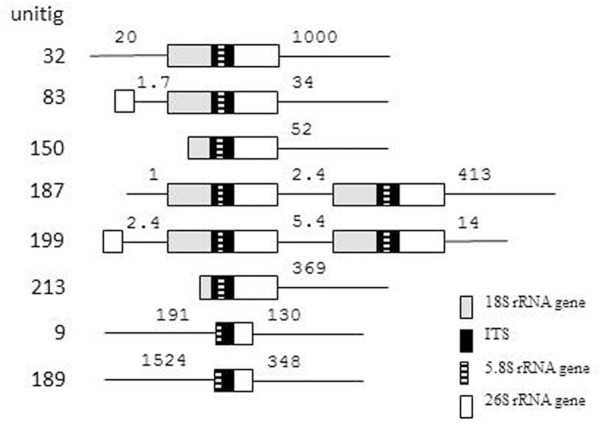
rDNA units in the genome sequence of M. fructicola CBS 8853T. The numbers show length in kb.